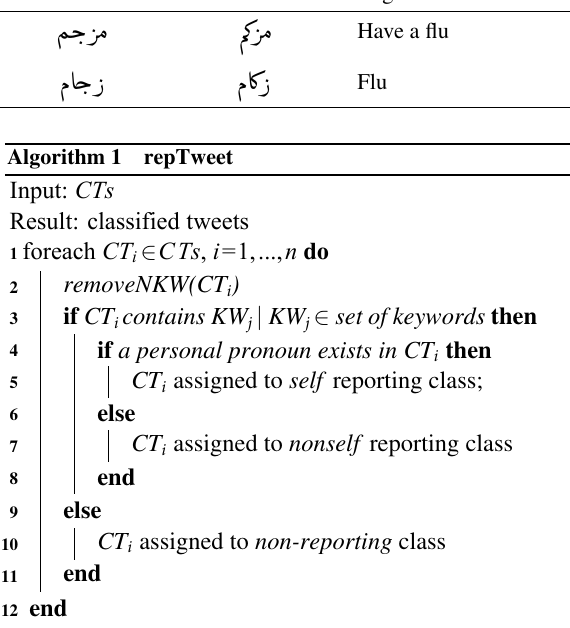
Table 5 Examples of Influenza keywords in the UAE dialect. UAE dialect Standard Arabic English translation